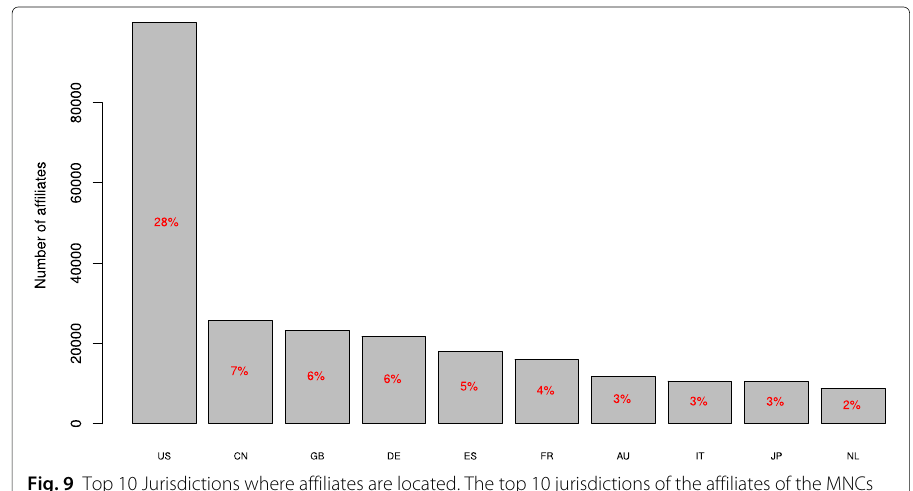
Fig. 9 Top 10 Jurisdictions where affiliates are located. The top 10 jurisdictions of the affiliates of the MNCs subject to this analysis. The horizontal axis indicates the locations, the vertical axis indicates the number of affiliates, and the labels indicate the percentage accounting for the total number of the affiliates. CN is mainland China; GB is the UK; DE is Germany; ES is Spain; FR is France; AU is Austria; IT is Italy; JP is Japan; and NL is the Netherlands headquarters. Germany (DE) and France (FR) also have many headquarters, compared with the other jurisdictions. Second bar plot shows regarding the “holding” companies. The Netherlands (NL), the US, and the UK (GB) are remarkable as the locations of the “holding” companies. Germany (DE) and Spain (ES) have more the “holding” companies, compared with the other jurisdictions. Third bar plot shows regarding the “holding and